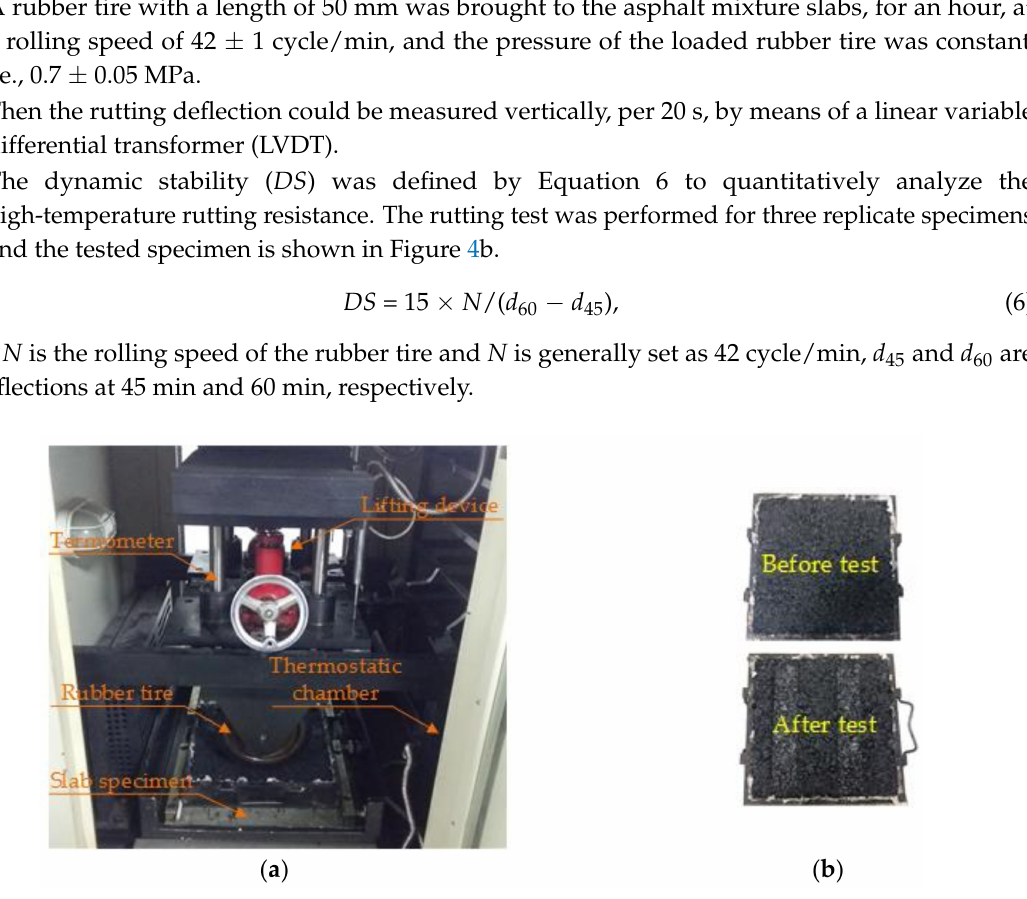
Figure 4. Rutting test in this paper: ( a ) Rutting test; and ( b ) slab